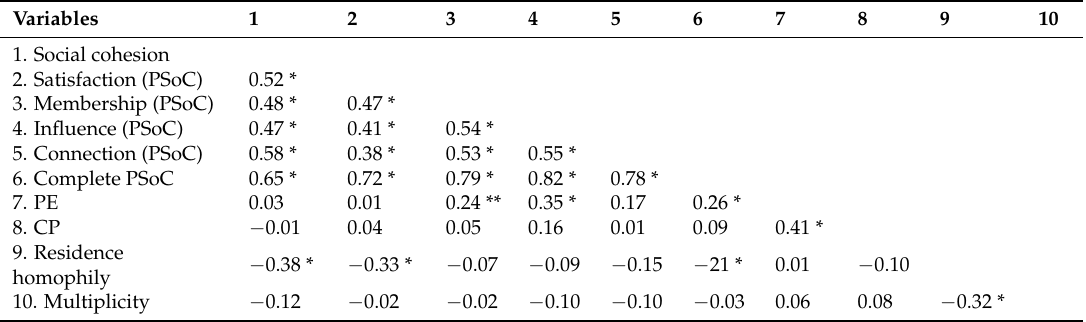
Table 3. Matrix of bivariate correlations between the